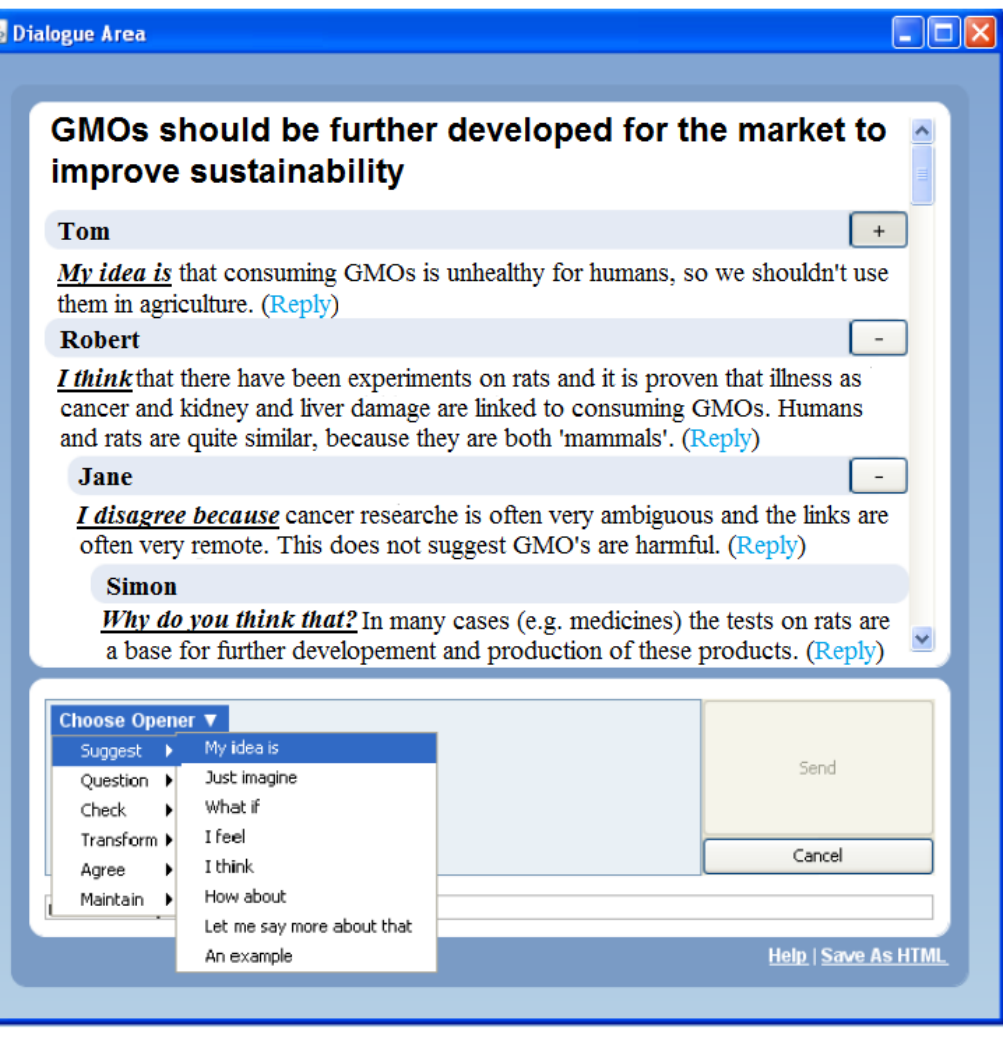
Figure 1. A screenshot of the digital dialogue game with associated sentence